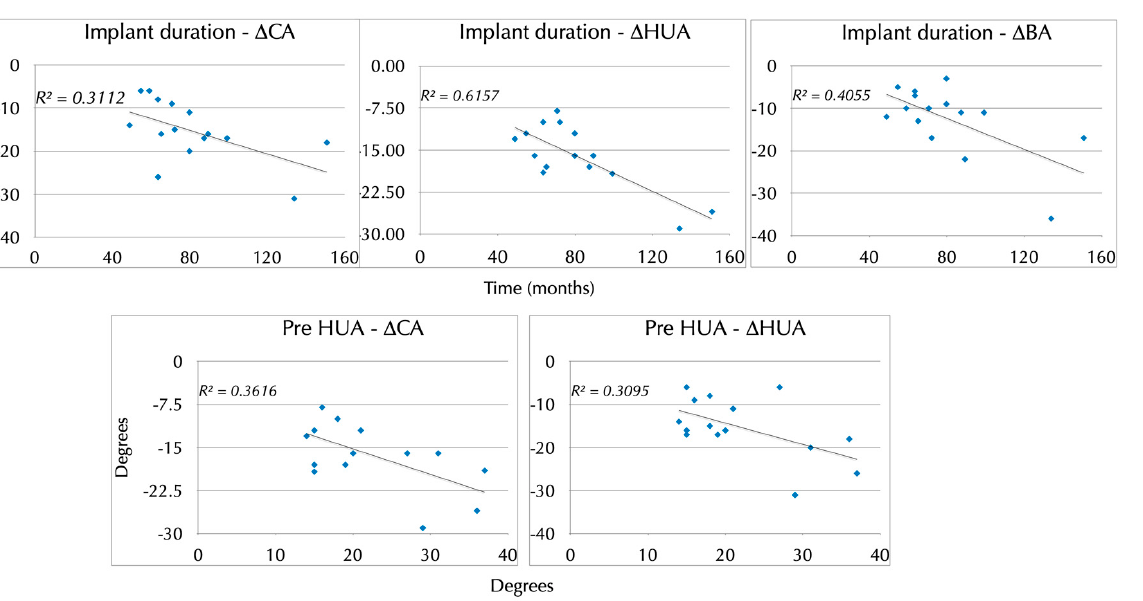
Figure 7. Lateral radiographs of the elbow of the same patient in Figure 5, showing an improvement in the radiological parameters, with values closer to normal in the last radiological control. SCA, shaft-condylar angle, LCHA, lateral capitellohumeral angle.